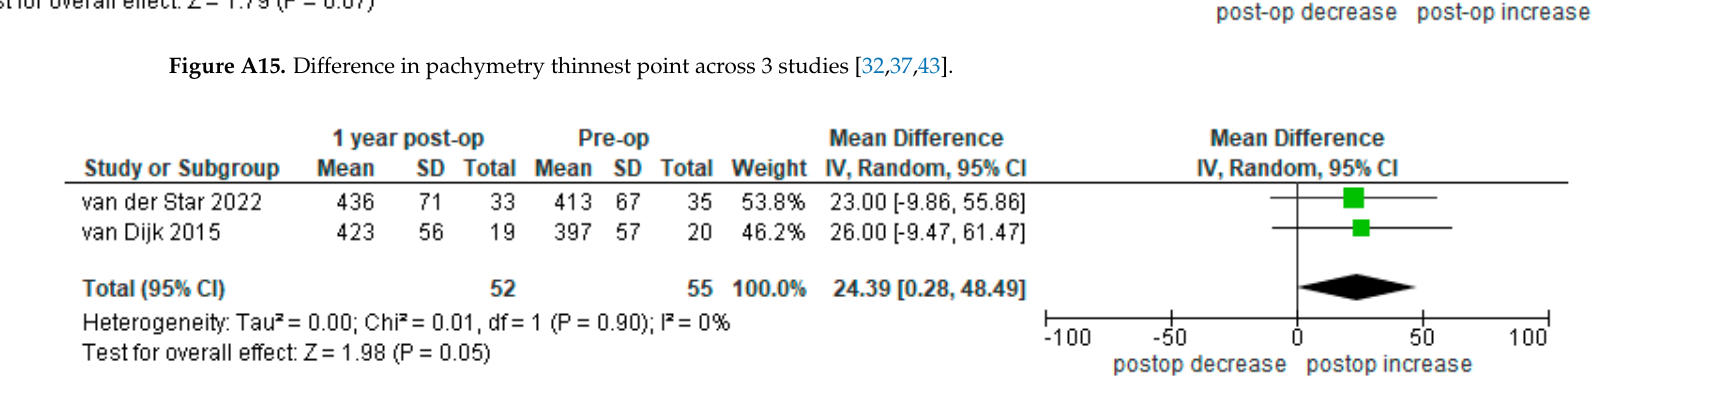
Figure A16. Difference in pachymetry central point across 2 studies Figure A16. Di ff erence in pachymetry central point across 2 studies [37,43].